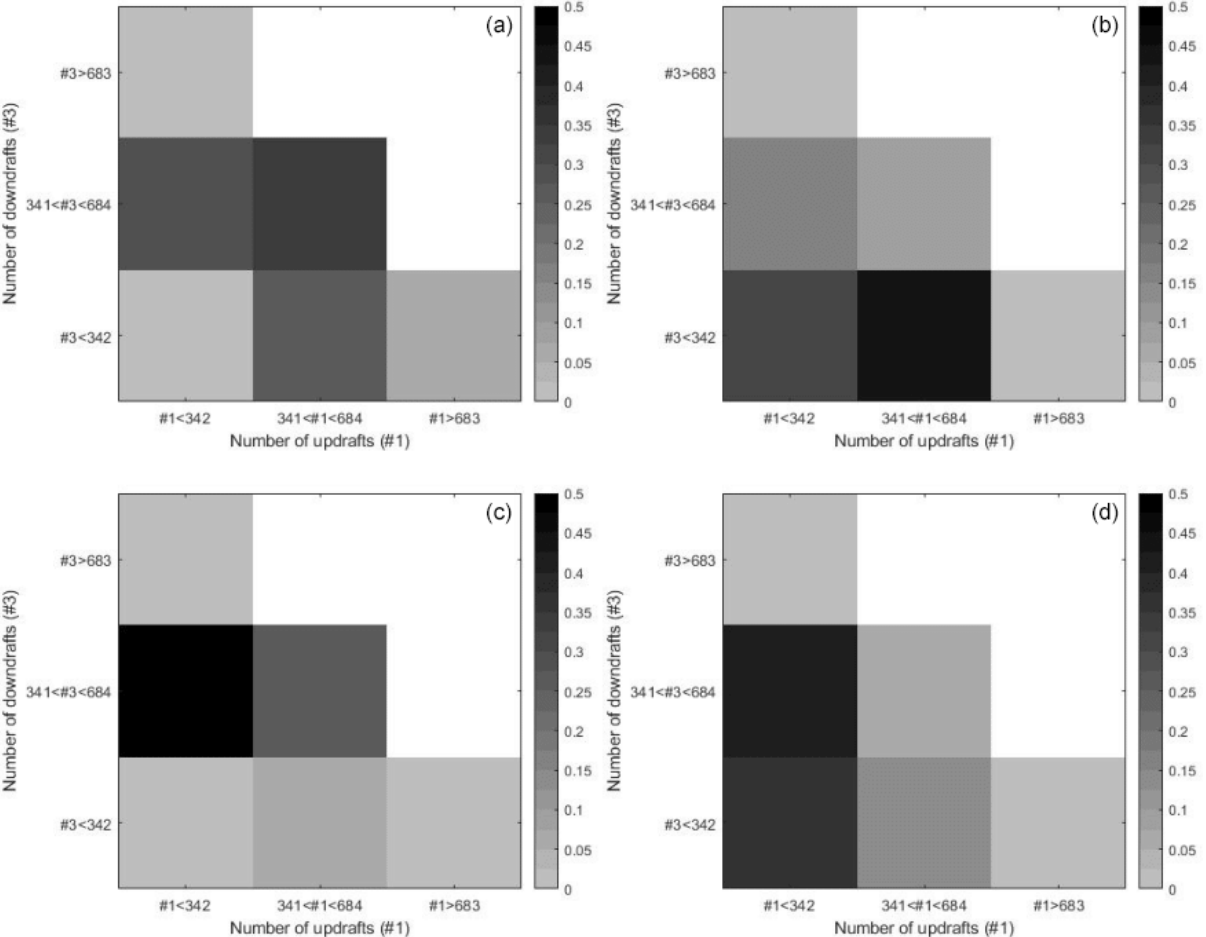
Figure 8. Histograms show probabilities of numbers of updrafts (#1) and downdrafts (#3) conditioned on high (a, b) and low (c, d) latent states. Panels (a) and (c) present day data and panels (b) and (d) the night data. CAPE and vertical velocity data correspond to the data applied in Fig.